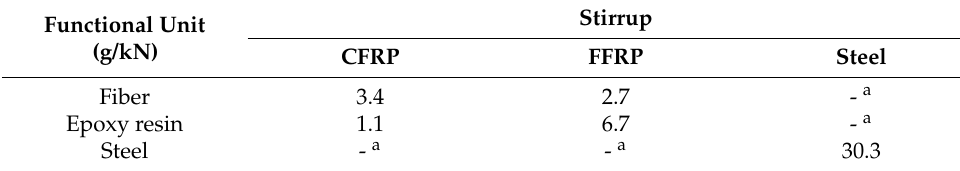
Table 5. Functional unit.